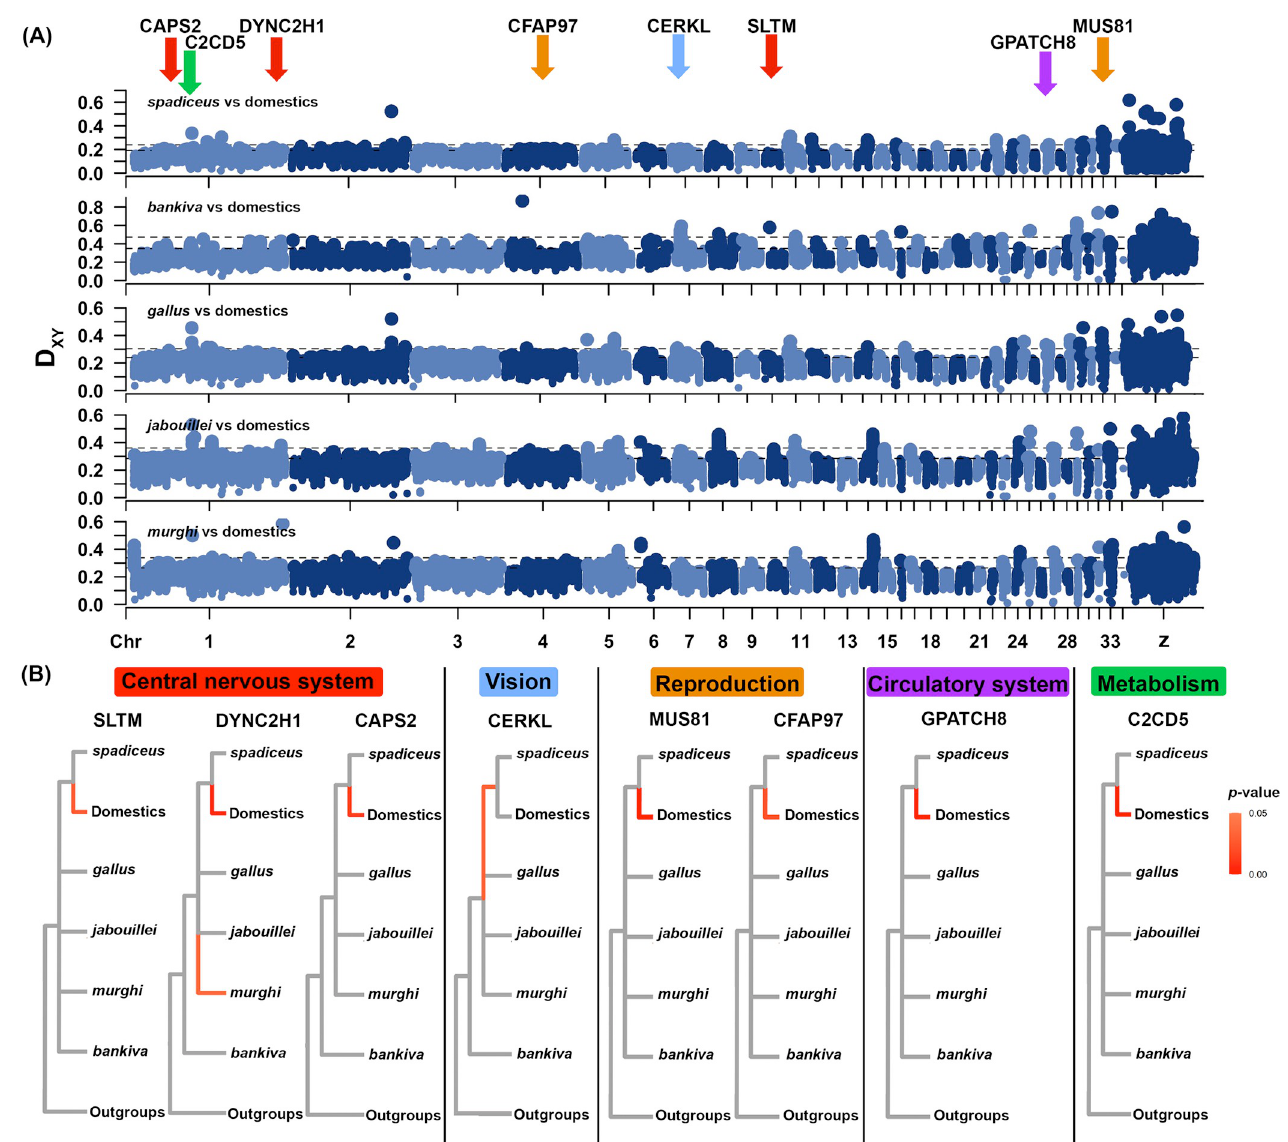
Fig 3. Positive selection on genomic islands of differentiation between chickens and wild red junglefowl. (A) D XY (pairwise divergence) between historic wild individuals of each red junglefowl subspecies versus modern chickens in 50kb sliding windows with a step size of 10kb across the chicken reference genome. Alternating hues of blue denote different chromosomes and the horizontal black dotted lines denote the 99 th percentile of D XY of autosomes (bottom) and the Z chromosome (top). Arrows indicate genic regions located within genomic islands of high differentiation between chickens and junglefowl which are under selection in domestic chickens; their colors refer to the main function of genes following (B). (B) Branches under positive selection that were inclusive of domestic chickens calculated using aBSREL (red: uncorrected p- value � 0.05) for genes that are highly divergent between chickens and wild junglefowl. Seven outgroups across the avian phylogeny were used in this analysis (signatures of selection in outgroups not depicted, see S6